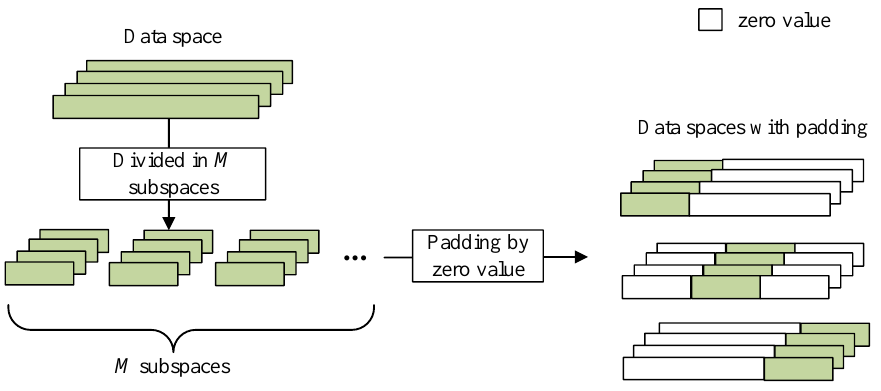
Figure 1. The data processing flow chart of codebook generation.